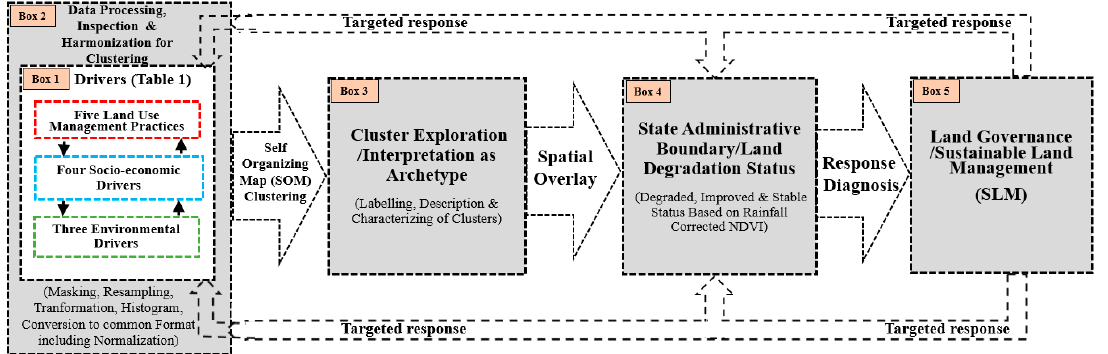
Figure 3. The conceptual framework.